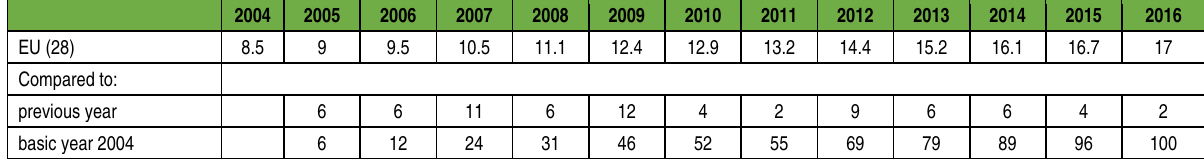
Table 2. Growth rate of share of renewable energy in gross final energy consumption in the EU countries